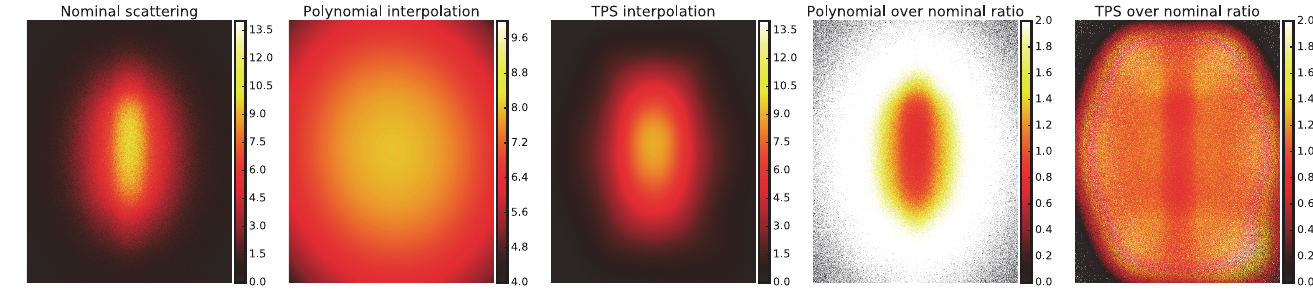
Fig 13. Scattering functions computed for the simulated